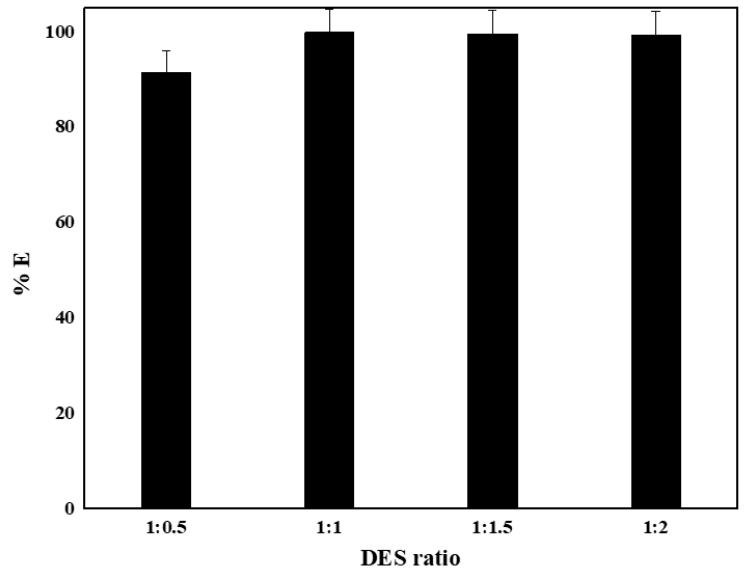
Figure 9. Effect of DES molar ratio (HBA:HBD) on MB extraction efficiency. [MB] = 200 mg dm − 3 ; T = 25.0 °C .